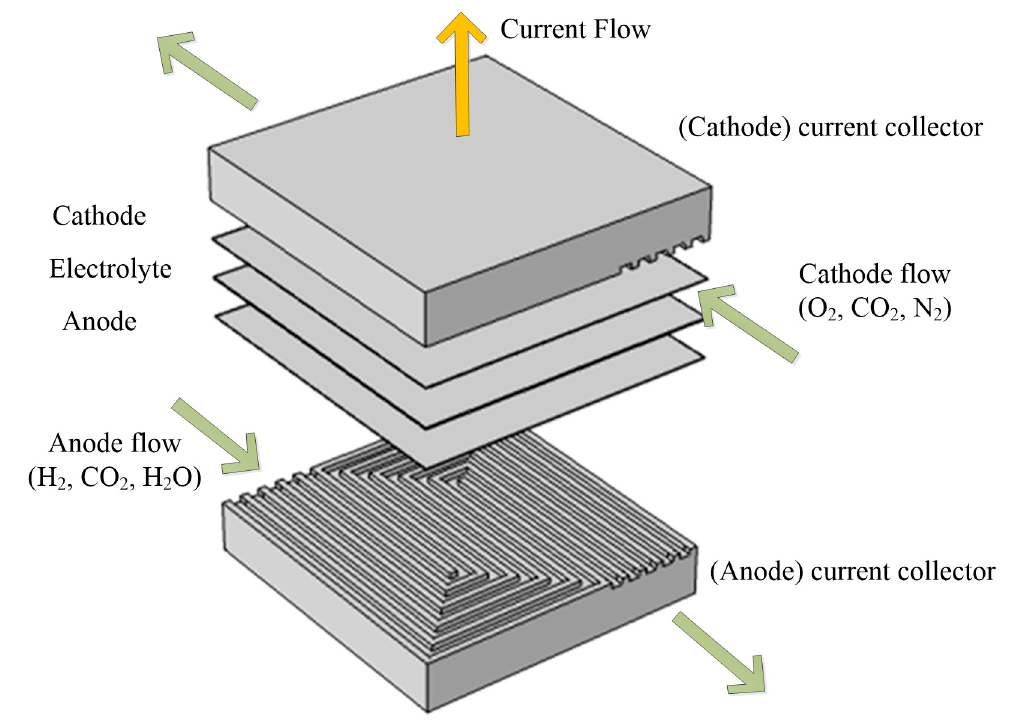
Figure 1. Structure of the MCFC single cell.